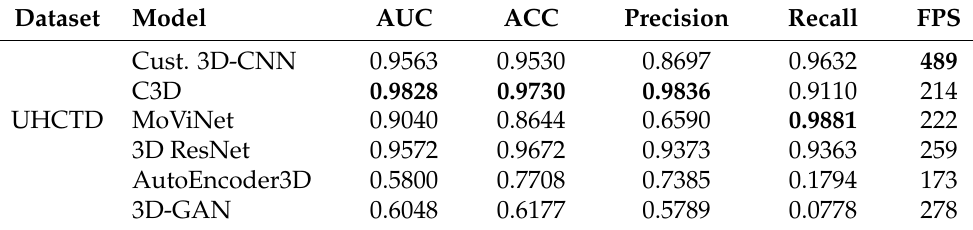
Table 4. Comparison among the six experimented deep learning 3D methods on the external UHCTD